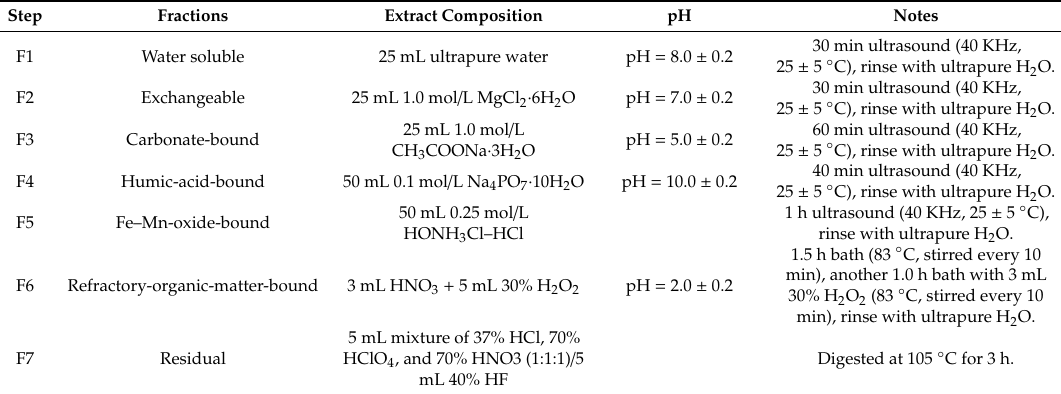
Table 1. Sequential extraction methods for Cd in di ff erent depth soils from the study